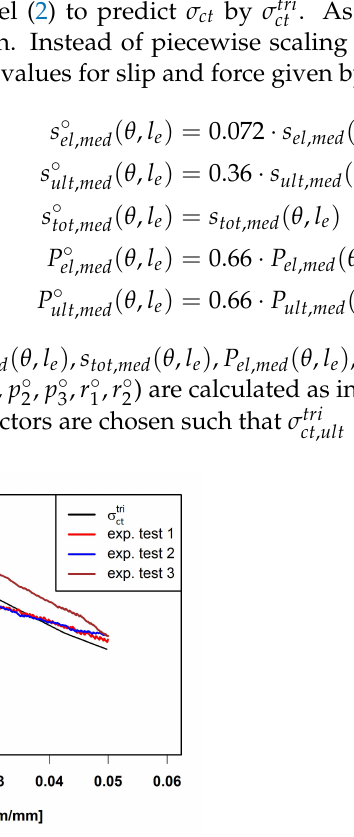
( ε ) based on the trilinear ct